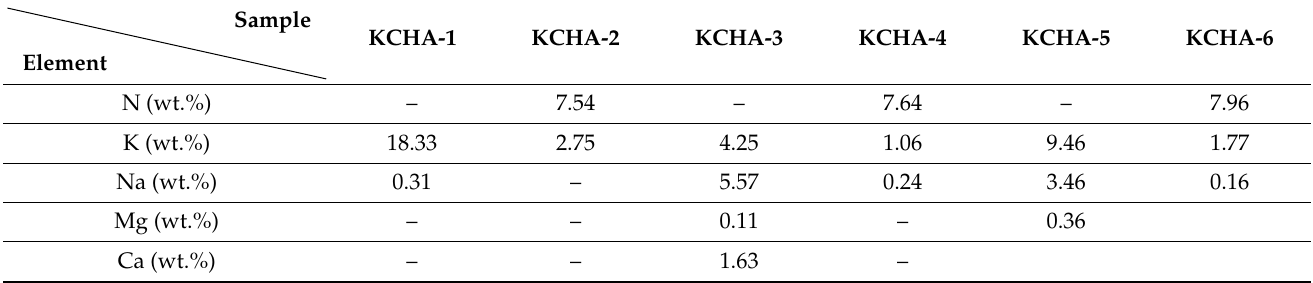
Table 2. Weight %s of elements N, K, Na, Mg, and Ca as determined using